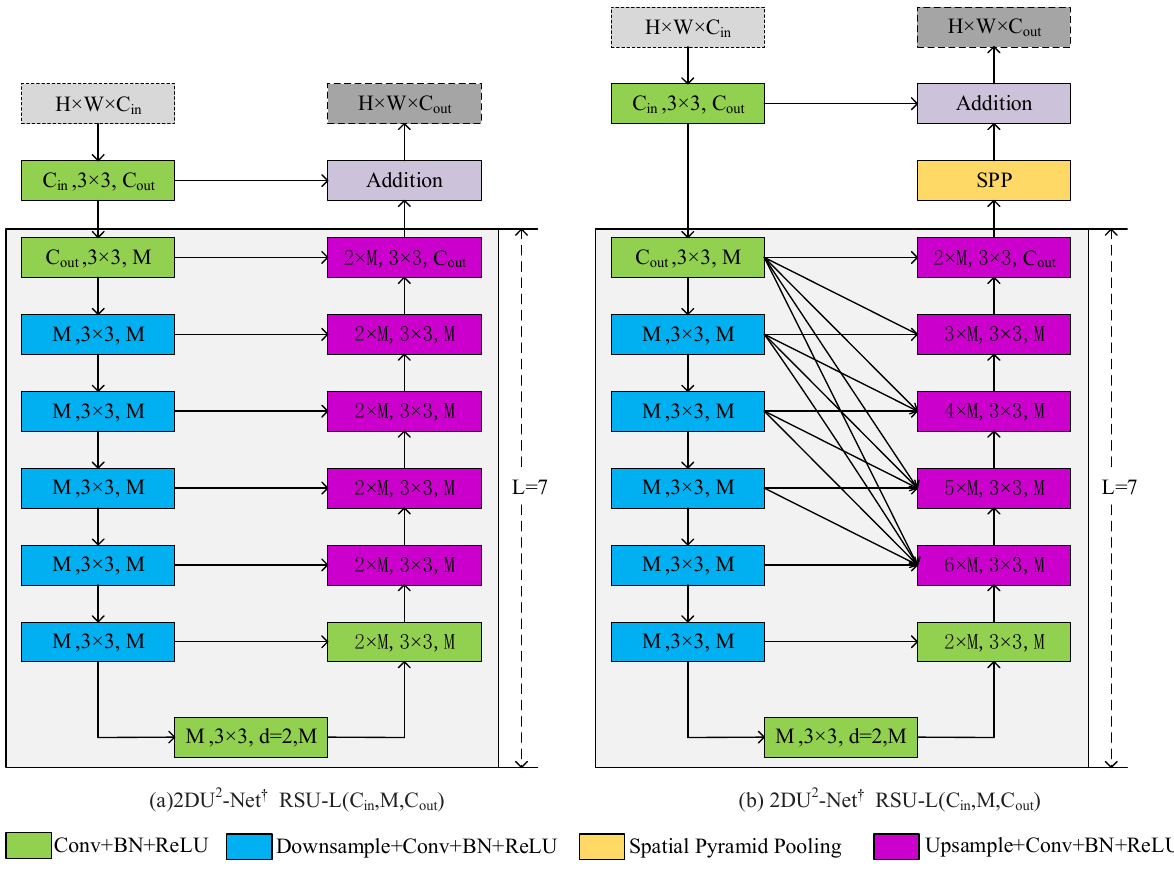
Figure 3. Internal structure of two residual U ‐ blocks: ( a ) residual U ‐ block ( b ) and multiscale con ‐ nected residual U ‐ block.